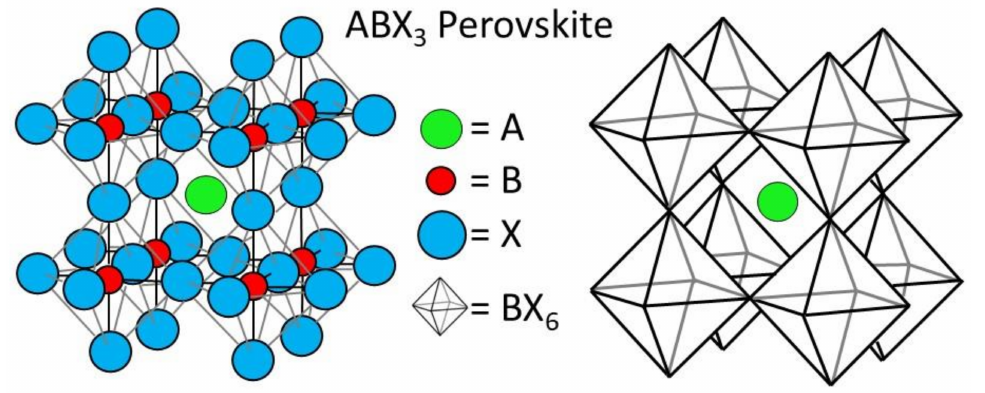
Figure 3. Crystal lattice of the ABX 3 perovskite